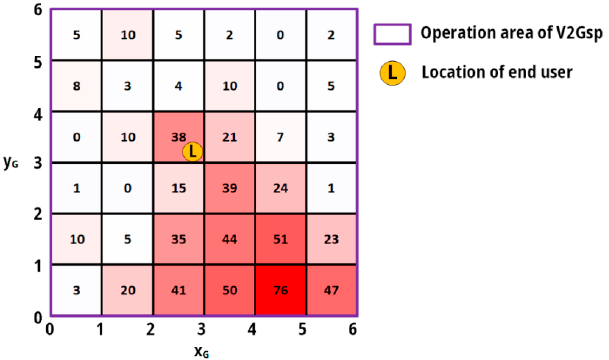
Figure 8. Grid of the assumed operation area of V2Gsp.